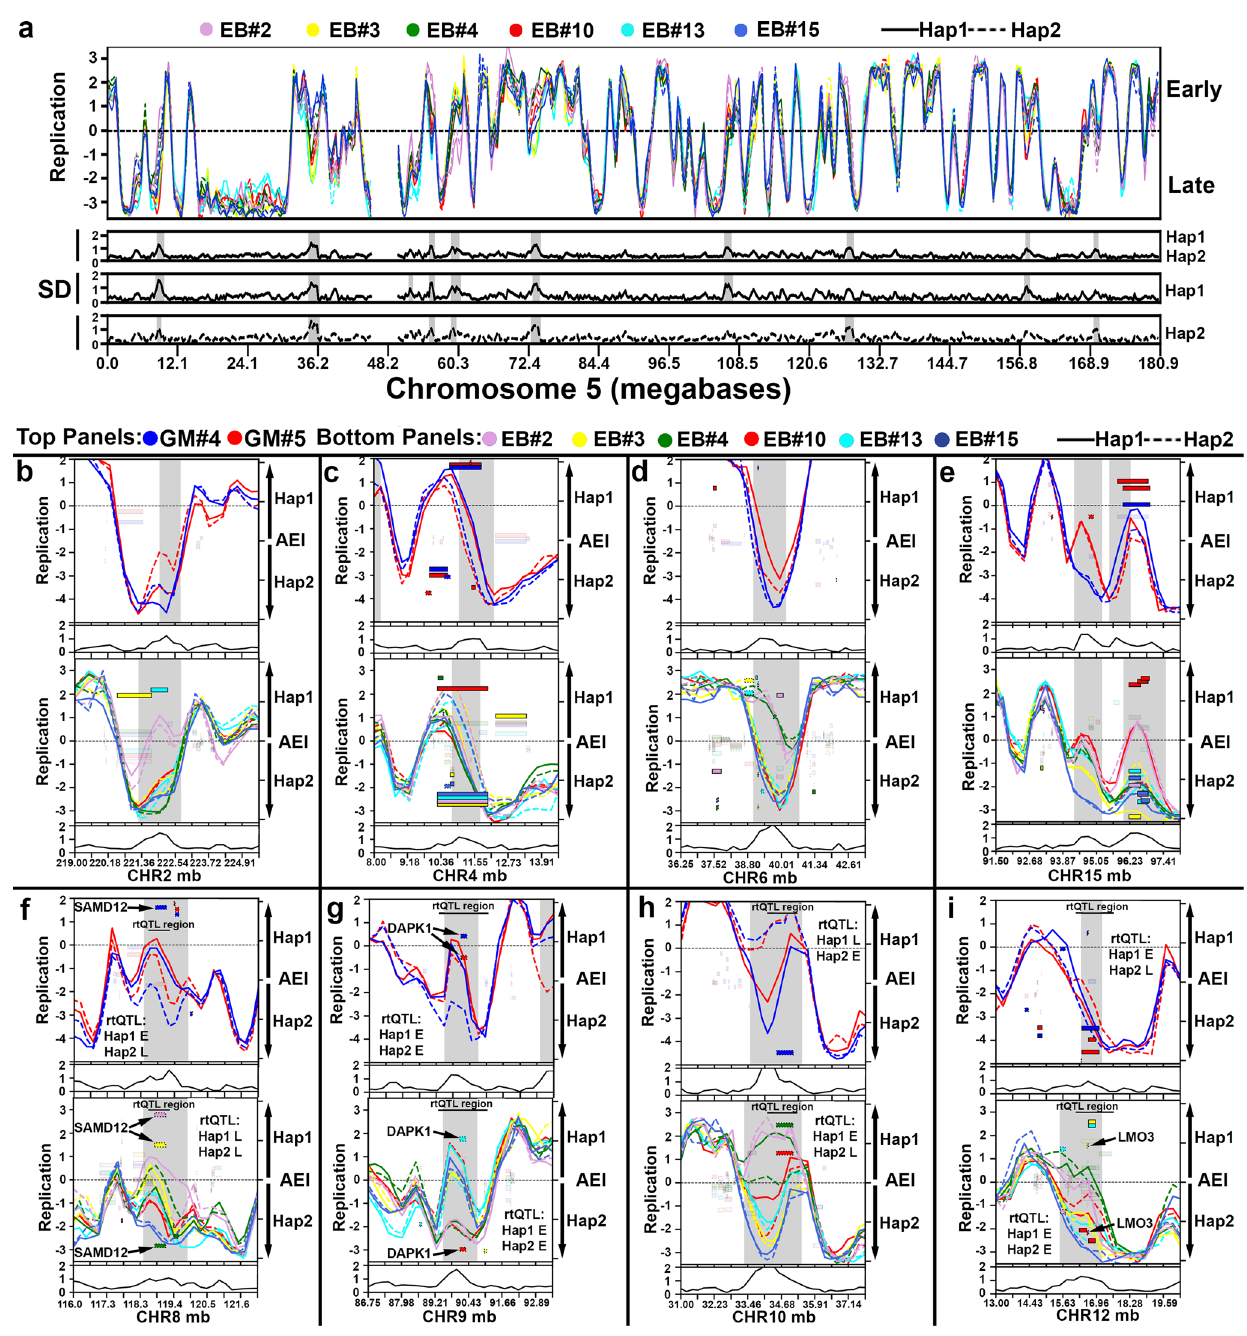
Fig. 4 | Haplotype phased analysis of ASRT on autosomes. a Chromosome 5 RT pro fi le from the 6 EB3_2 clones, highlighting regions with standard deviation (SD)>1fromboththe “ combinedalleleRTpro fi le ” (Hap1andHap2)andfromthe “ allele-restricted RT pro fi le ” separately (Hap1 or Hap2). b – i Representative examples of regions present in both GM12878 (top panels) and EB3_2 (bottom panels) clones with variable epigenetic replication timing between alleles. Each clone was color coded as shown, with haplotype 1 shown as a solid line, and haplotype 2 shown as a dotted line for both sets of clones. The left Y axis shows the replication timing (Early/Late) pro fi les. The SD of the replication timing